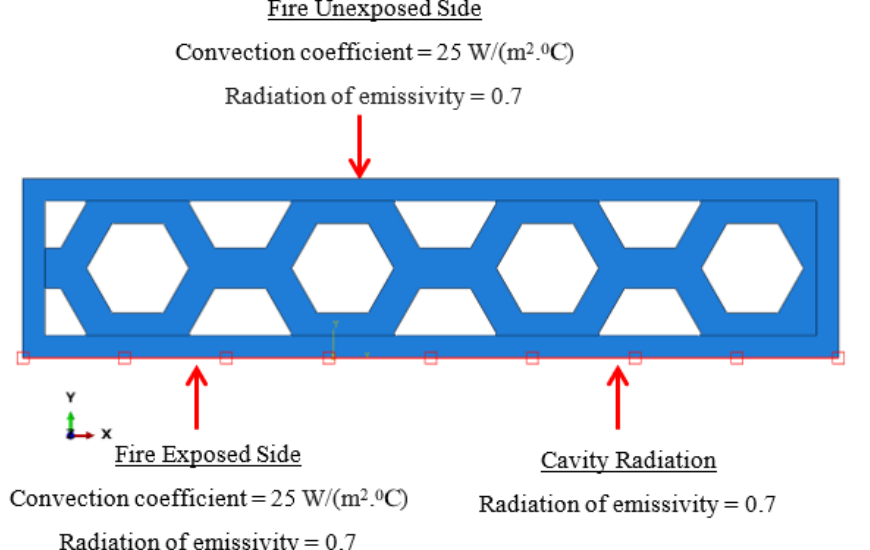
Figure 8. Boundary conditions applied on the developed model.